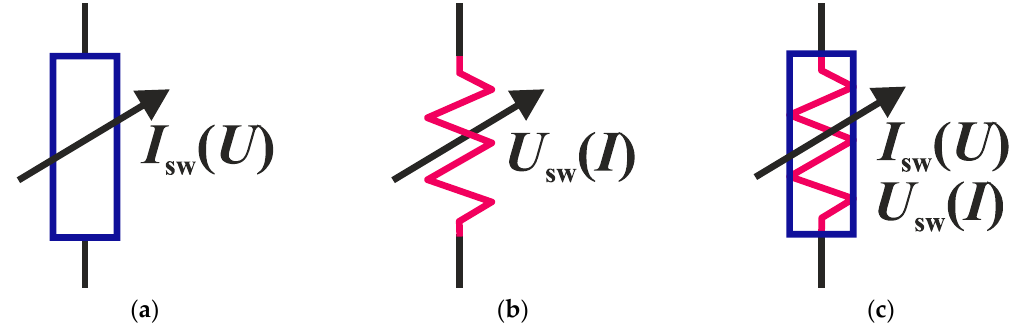
Figure 4. Designation for a switching element controlled by a voltage ( a ), current ( b ) and, optionally, current or voltage ( c ).